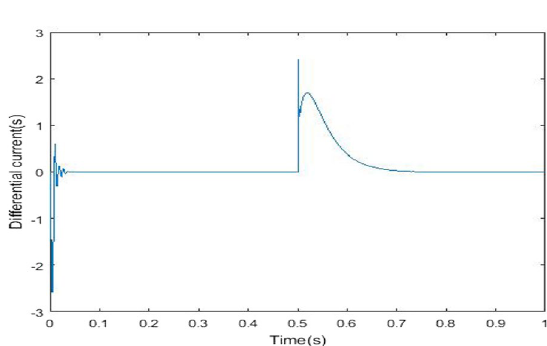
Fig. 7 Positive to negative fault on HVDC line at 25 km